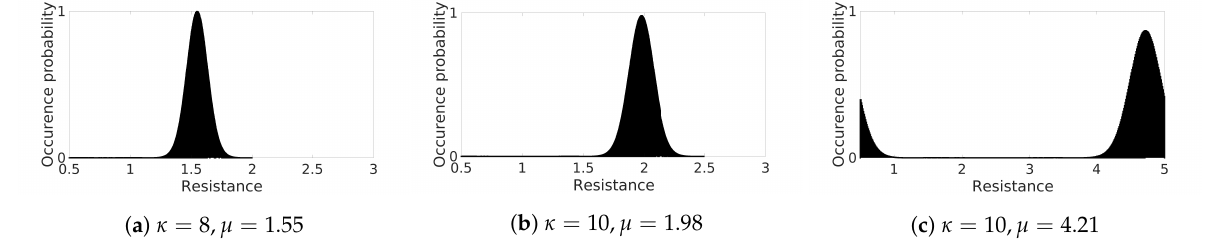
Figure 7. Von Mises distribution functions for R V spatial characterization.